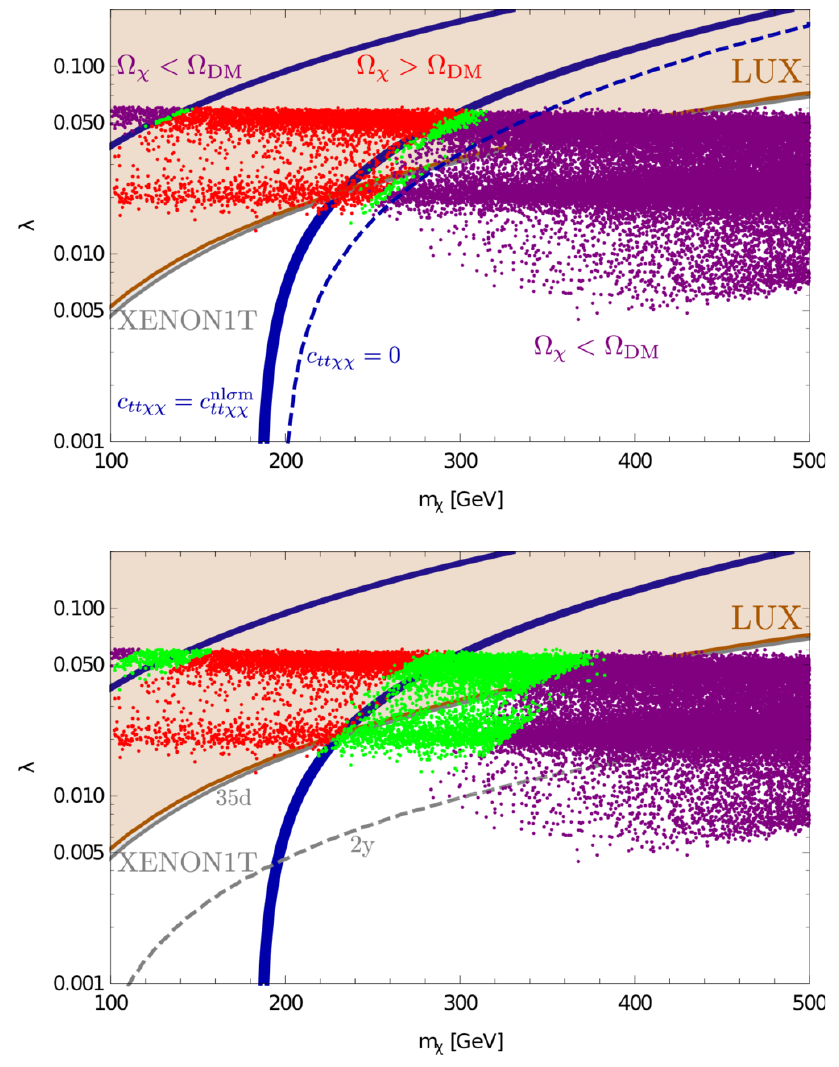
Figure 9 . Distributions in the ( m (cid:31) ; (cid:21) ) plane that summarize our analysis of DM phenomenology. The points have di(cid:11)erent colors depending on whether they are compatible with (green), exceed (red) or undershoot (purple) the observed value of the DM relic abundance. In the upper (lower) panel, the theoretical uncertainty of 50% on the annihilation cross section is neglected (included). See the main text for further explanations on the meaning of the di(cid:11)erent curves.